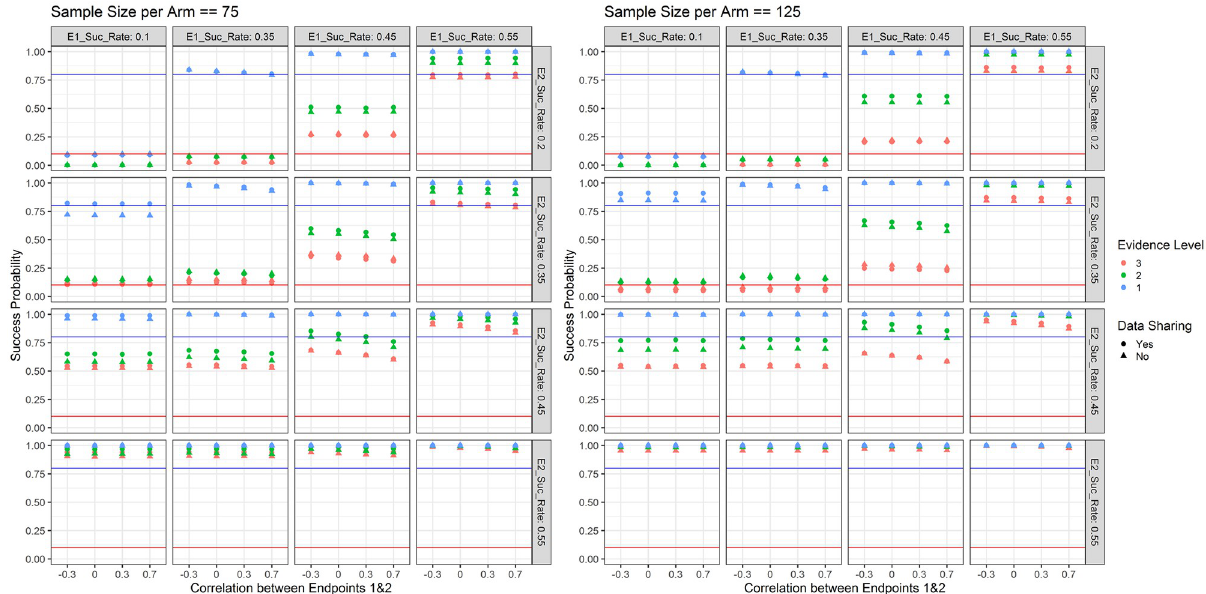
Fig 7. Success probabilities for the treatment arm with respect to the response rate for endpoint 1 (E1_Suc_Rate; columns), the response rate for endpoint 2 (E2_Suc_Rate; rows), the correlation between the two endpoints (x-axis), the type of data sharing used (point shape), the level of evidence required (colour) and the planned sample size per cohort (left panel 150 and right panel 250). The blue horizontal line marks 80% as a common target for the power and the red horizontal line marks 10% as a common target for type 1 error in early phase clinical trials. Level of evidence required refers to how many of the Bayesian efficacy rules specified in section 2.2 need to simultaneously hold for a treatment to be declared efficacious.